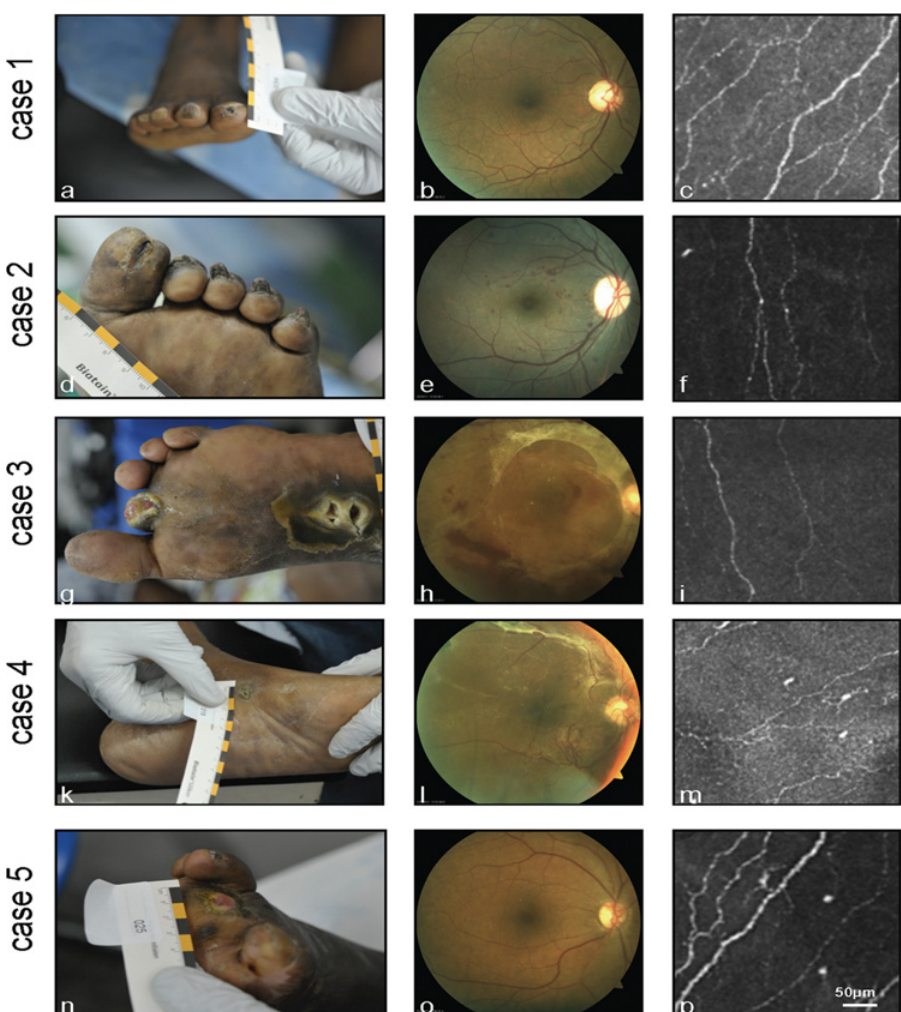
Fig 1. Representative cases. Case 1: 62-year-old male patient, DM duration 9 years, HbA 1c 6.5%, NDS 4 points; Wagner 1 (a), no signs of DR (b), normal SBP morphology (NFD = 0.011 μ m/ μ m 2 ) (c). Case 2: 62-year-old female patient, DM duration 7 years, HbA 1c 9.4%, NDS 5 points; Wagner 2 (d), advanced non- proliferative DR (e), moderate decrease in confocal SBP parameters (NFD = 0.010 μ m/ μ m 2 ) (f). Case 3: 44-year-old female patient, DM duration 9 years, HbA 1c 11%, NDS 9 points; Wagner 5 (g), proliferative DR with retinal detachment (h), moderate decrease in confocal SBP parameters (NFD = 0.011 μ m/ μ m 2 ) (i). Case 4: 59-year-old female patient, DM duration 31 years, HbA 1c 10.4%, NDS 6 points; Wagner 0 (k), proliferative DR (l), moderate decrease in confocal SBP parameters (NFD = 0.008 μ m/ μ m 2 ) (m). Case 5: 58-year-old female patient, DM duration 12 years, HbA 1c 8.2%, NDS 5 points; Wagner 5 (n), no signs of DR (o), normal SBP morphology (NFD = 0.014 μ m/ μ m 2 ) (p)